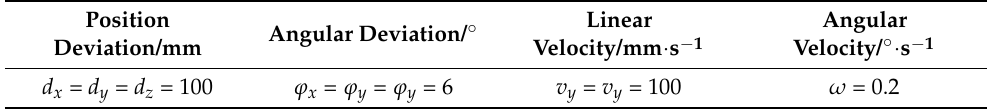
Table 4. The initial docking conditions of the synchronous docking